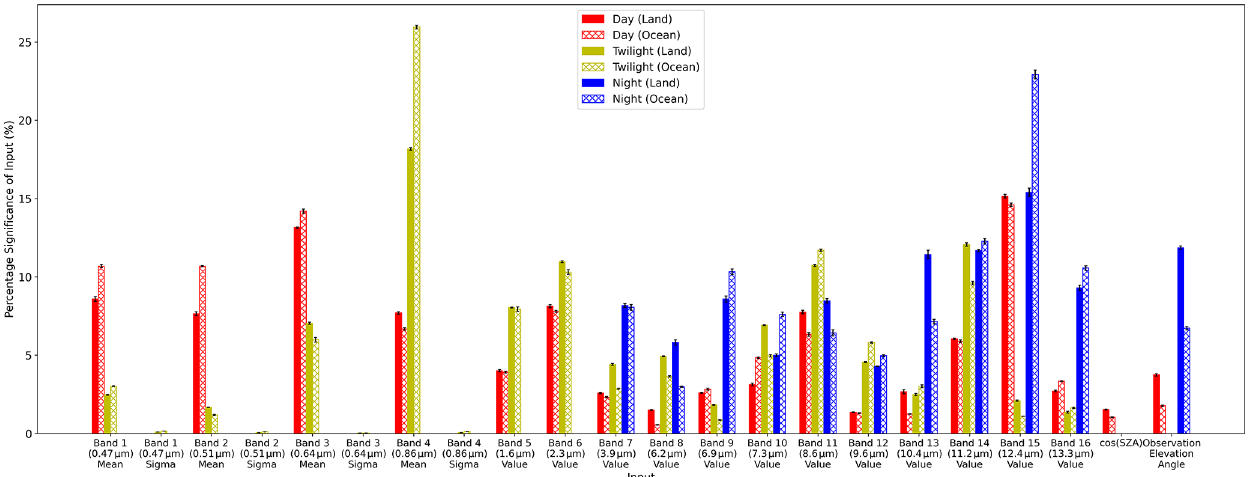
Figure 6. Plot summarising the output from the SHAP analysis. The SHAP values for each scenario, day, night, twilight, sea and land are normalised to 100. The results indicate the relative contribution of each input to defining the cloud